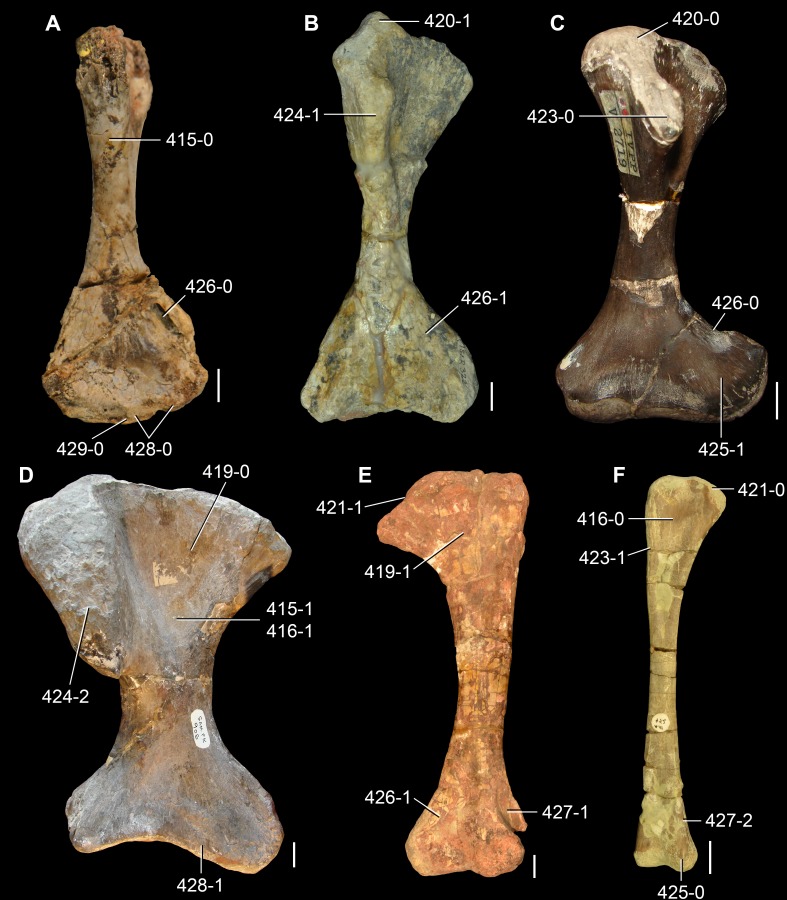
Humeri of Permo-Triassic neodiapsids in (A–D, F) anterior/dorsal and (E) posterior/ventral views.(A) Right element of Youngina capensis (BP/1/3859); (B) right element of Pamelaria dolichotrachela (ISI R322); (C) right element of “Chasmatosaurus” yuani (IVPP V2719); (D) right element of Erythrosuchus africanus (SAM-PK-905); (E) left element of Parasuchus hislopi (ISI R42, mirrored); and (F) left element of Silesaurus opolensis (ZPAL AbIII/452, mirrored). Numbers indicate character-states scored in the data matrix. Scale bars equal 2 mm in (A), 1 cm in (B, C, E, F), and 2 cm in (D).